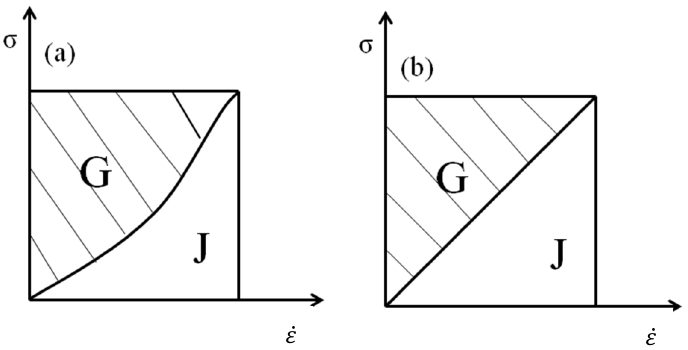
Figure 5. Material system energy dissipation map. ( a ) Nonideal energy dissipation map. ( b ) ideal energy dissipation map.